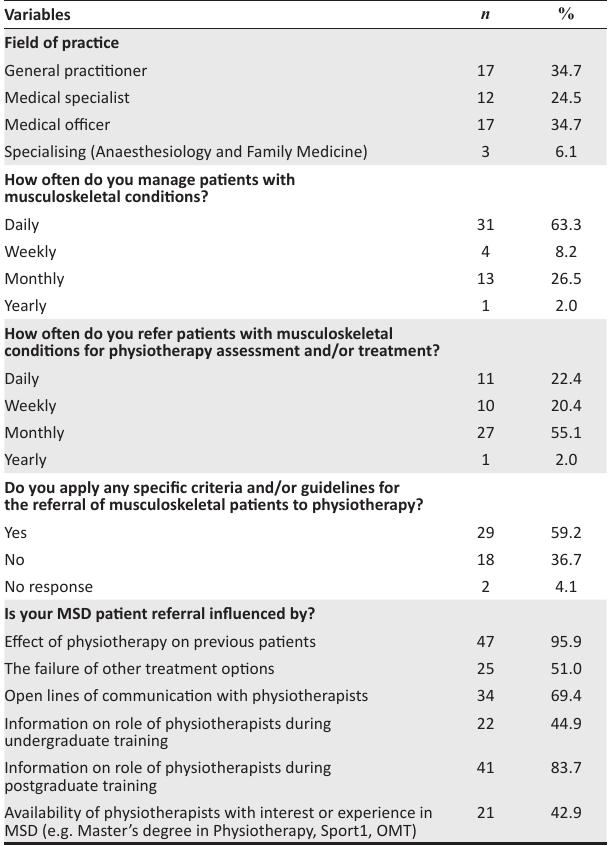
TABLE 1: Summary of results ( n = 49). Variables n